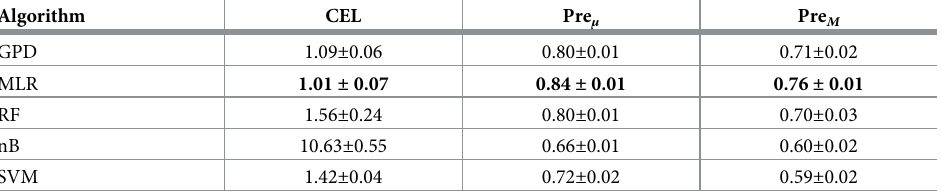
Table 1. Performances of different classifiers in terms of cross-entropy loss (CEL), micro- and macro-average pre- and Pre , respectively). Each score is computed across the 10-fold cross-validation and we provide the cisions (Pre μ M standard deviation. Bold scores highlight the best scores for each metric. Algorithm CEL Pre μ Pre M GPD 1.09 ± 0.06